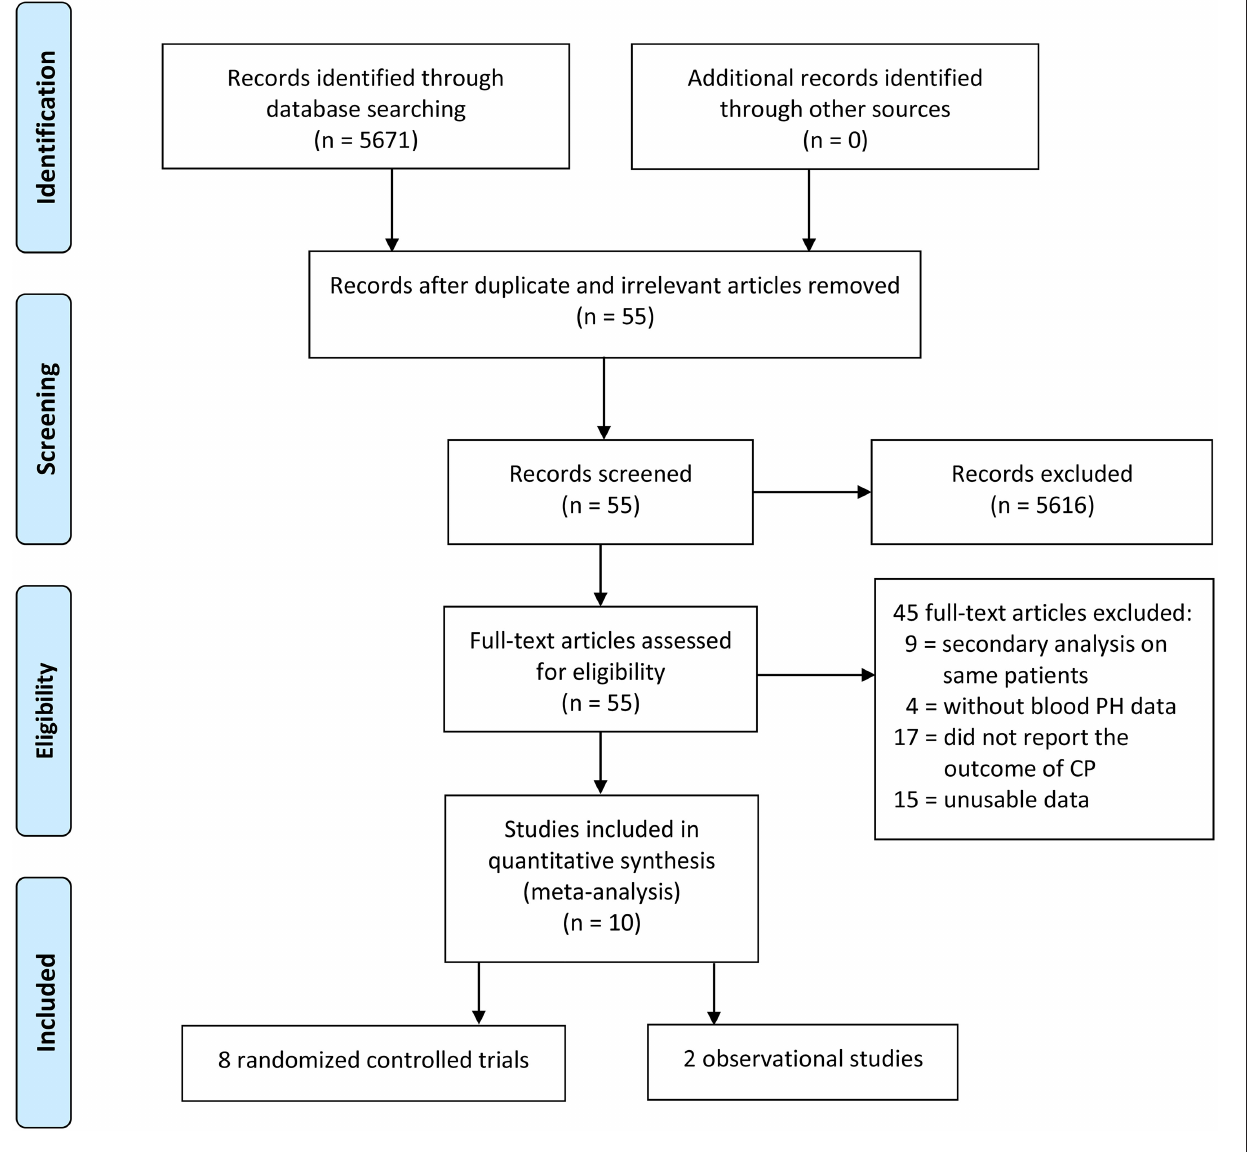
FIGURE 1 | Flow chart for study